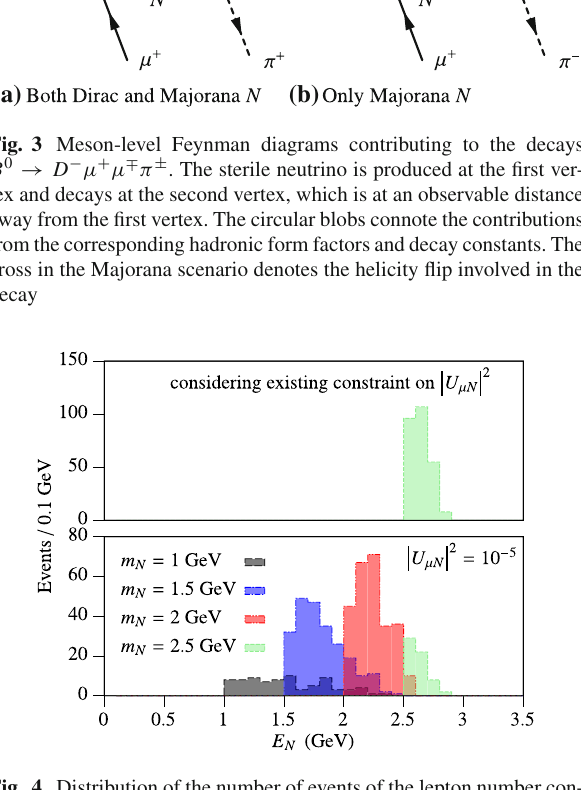
Fig. 4 Distribution of the number of events of the lepton number con- serving B → D μ ± μ ∓ π decays.Herewehaveconsideredthedisplaced vertices not larger than 1 m so that the events can be observed at Belle